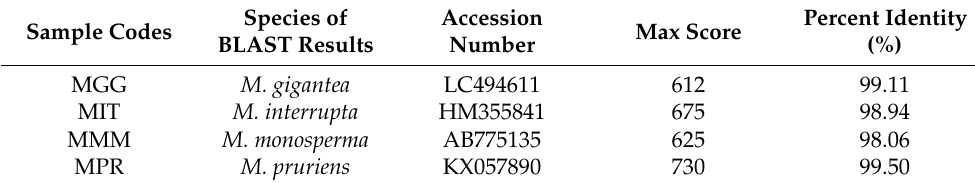
Table 2. The BLAST results of four Mucuna